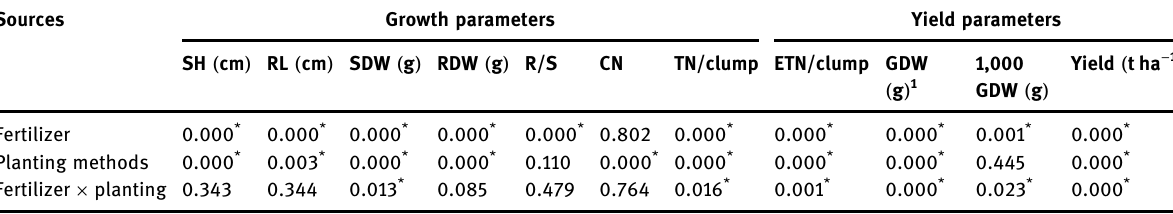
Table 2: The p - value and signi fi cance e ff ect of treatments on parameters based on ANOVA Sources Growth parameters